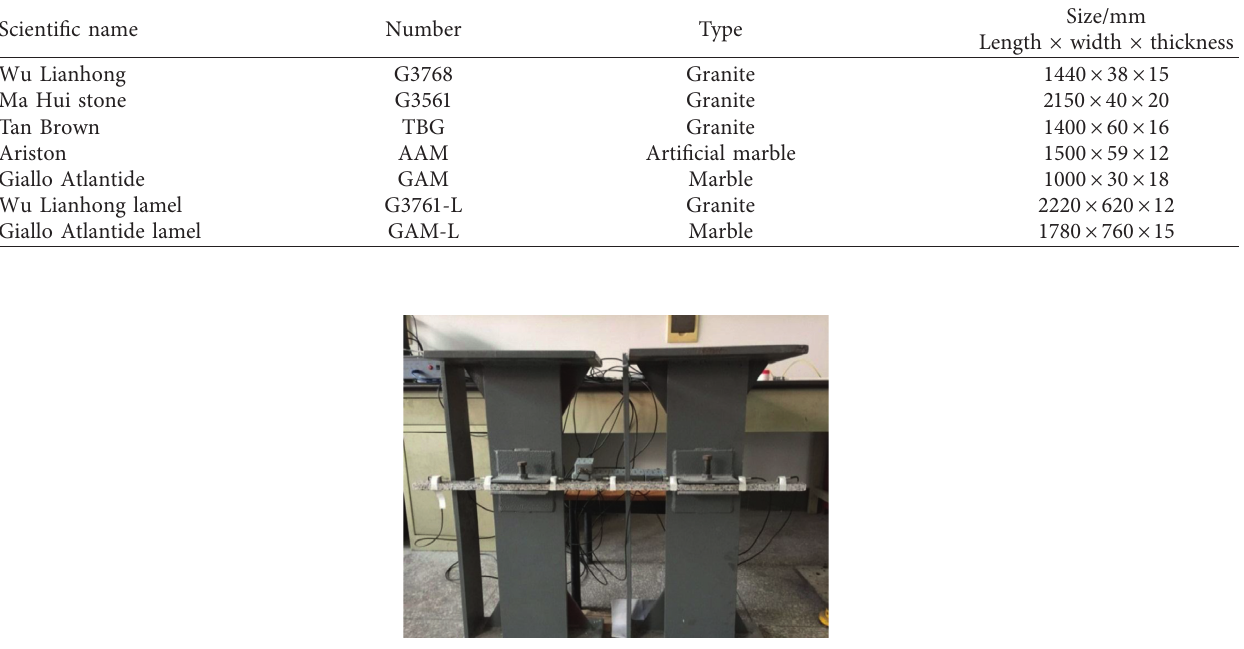
Table 1: Parameters of the rod-shaped and plate-shaped rock samples.